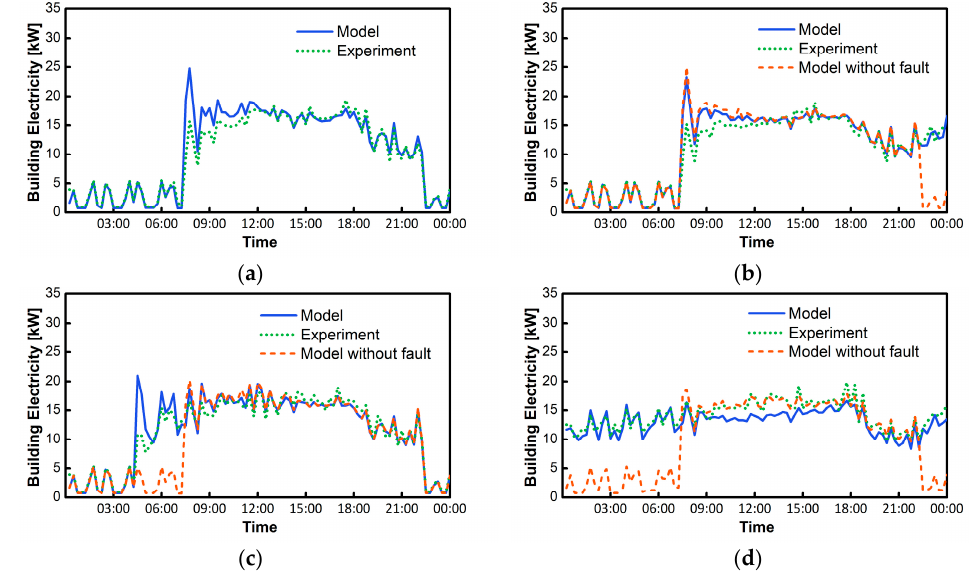
Figure 7. Total building electricity consumptions of baseline and faulted scenarios: HVAC setback error (summer). ( a ) baseline; ( b ) delayed onset; ( c ) early termination; ( d ) no setback.